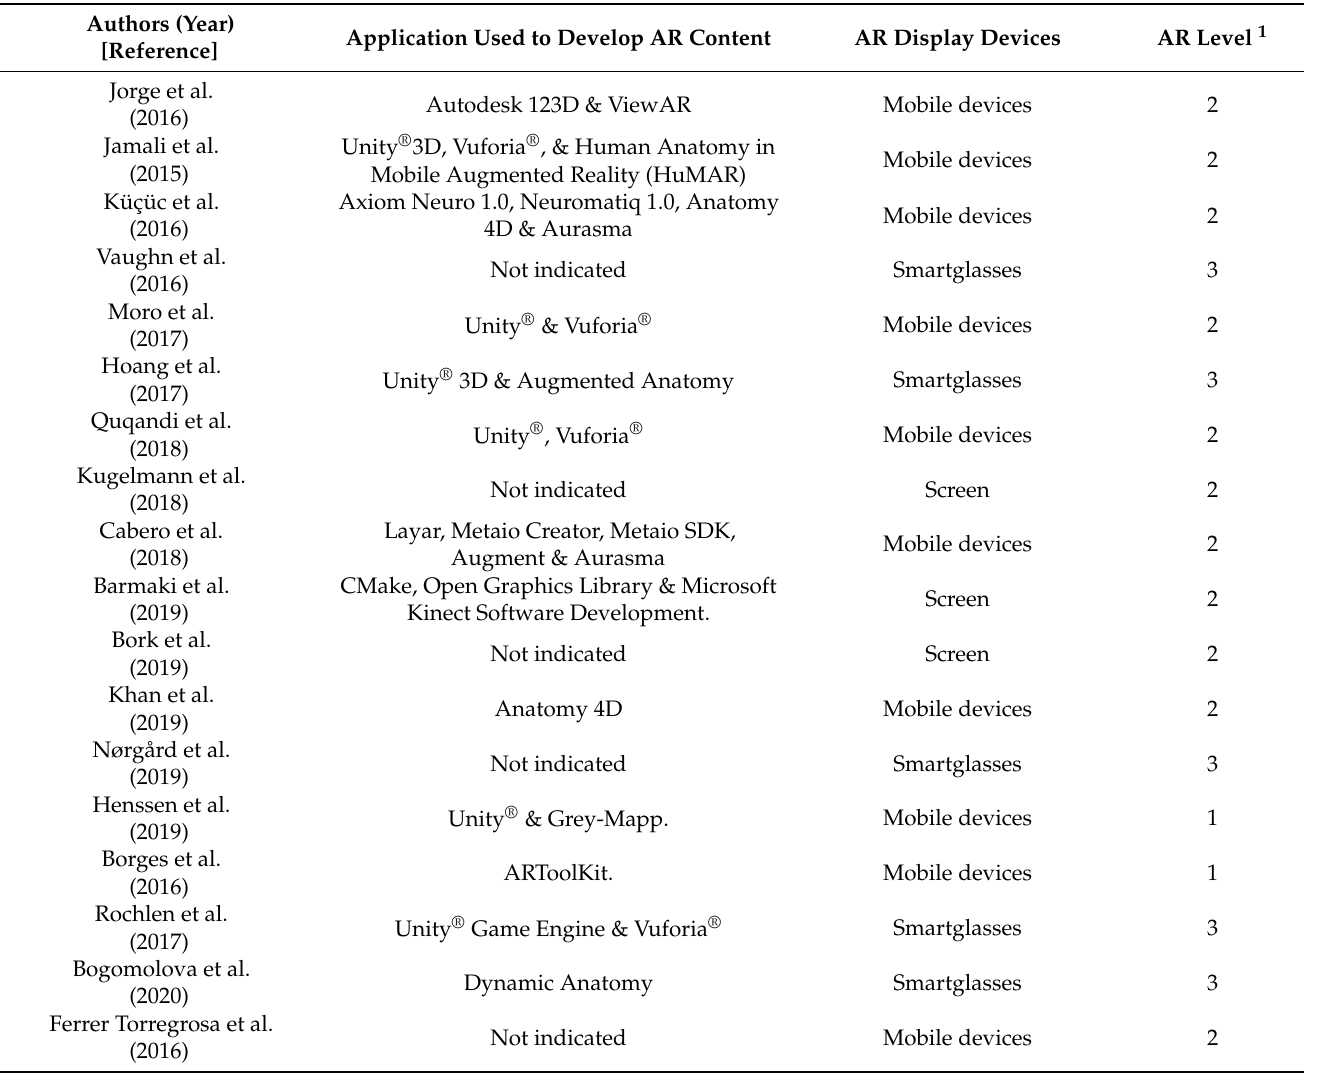
Table 3. Applications, electronic devices and AR